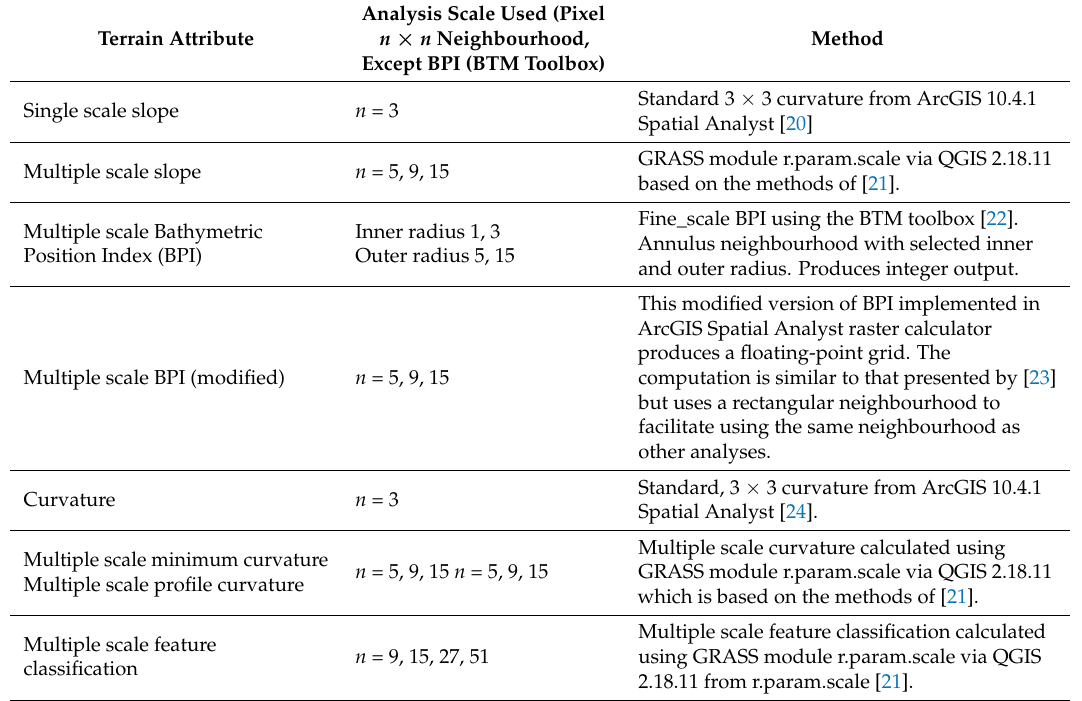
Table 1. Summary of pixel-based approaches to pockmark mapping in SEA2 Box 4, Witch Ground Basin. Analysis Scale Used (Pixel n × n Neighbourhood, Terrain Attribute